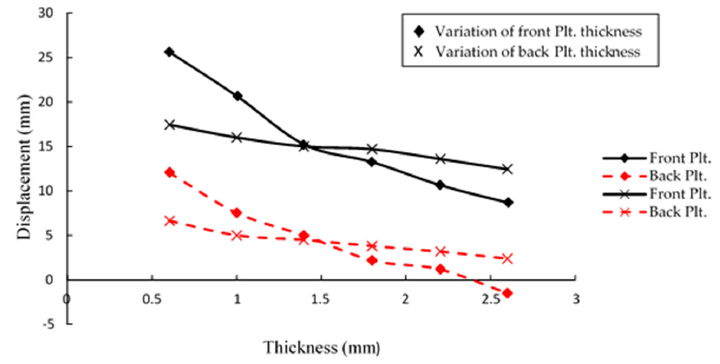
Figure 10. Central deformation with the face sheets thicknesses variation.